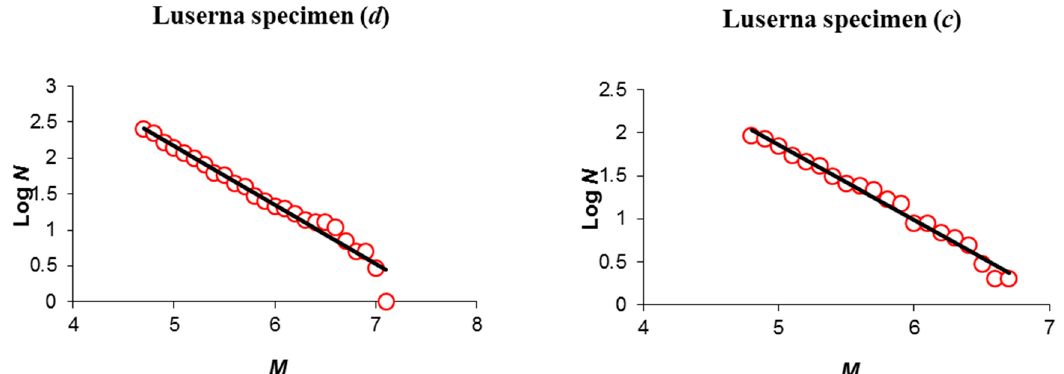
Figure 8. AE number N with magnitude greater than M as a function of M ( M = log 10 A ) represented by red circles; the negative slope of the fitting line is the b -value. Deviations from linearity occurring at larger magnitudes ( M ≥ 7) can be observed for the narrower specimen ( d ) (left panel), while the linear fit matches with experimental data of specimen ( c ) throughout the magnitude range (right panel).